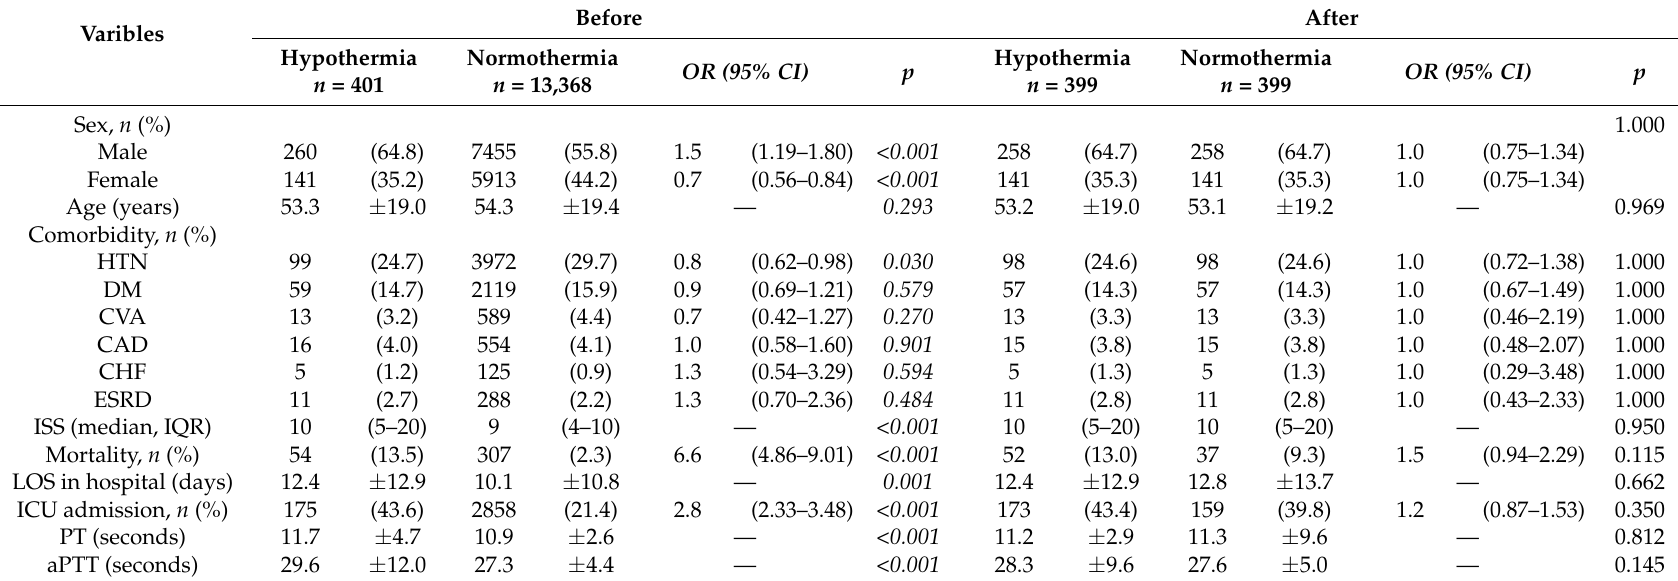
Table 6. Comparison of outcomes between study groups before and after propensity score